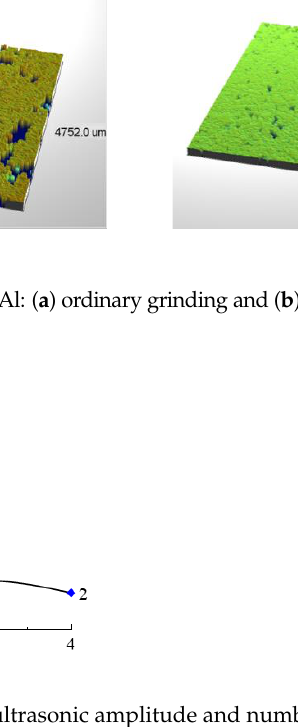
( d ) Figure 6. Relationships between surface roughness and each grinding factor after ultrasonic vibra- tion-assisted grinding. ( a ) linear speed of grinding wheel and surface roughness, ( b ) feed speed and surface roughness, ( c ) grinding depth and surface roughness, and ( d ) ultrasonic amplitude and surface roughness. As shown in Figure 6a, when grinding linear speed of grinding wheel v s increases from 2.512 m/s to 7.536 m/s, surface roughness R a decreases from 0.25 µm to 0.16 µm, because the shearing effect of the diamond abrasive particles on the tool for SiC particles increases with an increase in grinding linear speed of grinding wheel v s [13]. The force in